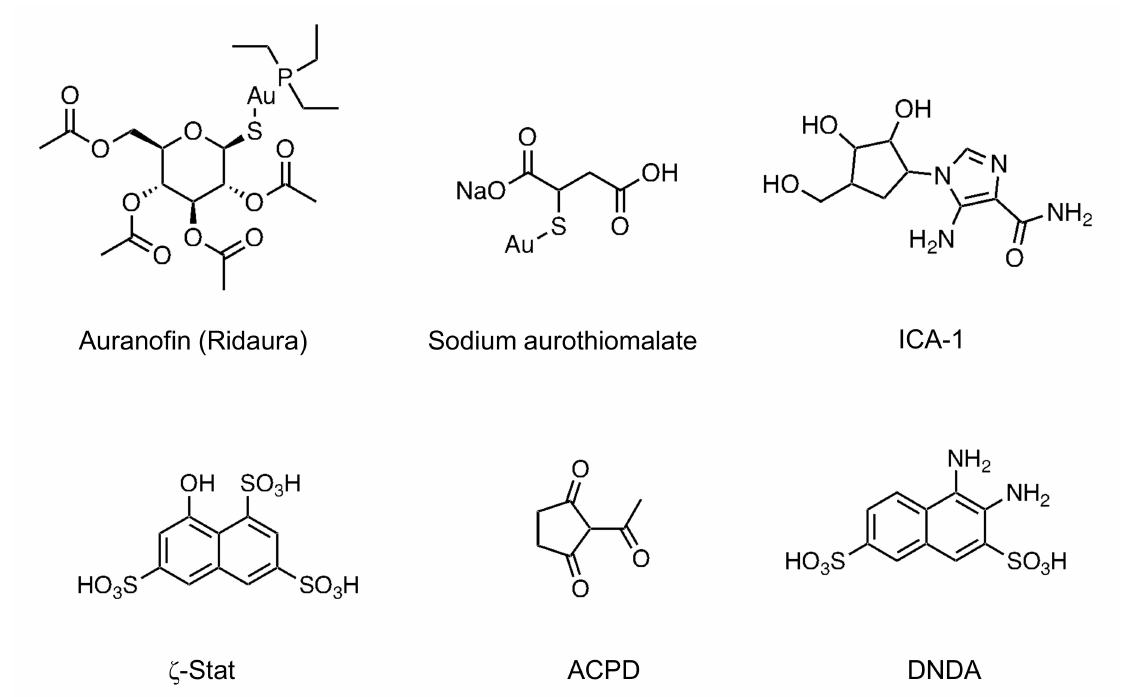
Figure 4. Chemical structure of atypical PKC inhibitors. These inhibitors show high potential inhibitory activity for PKC ι / λ (PKC λ is the mouse homolog of PKC ι ) and PKC ζ